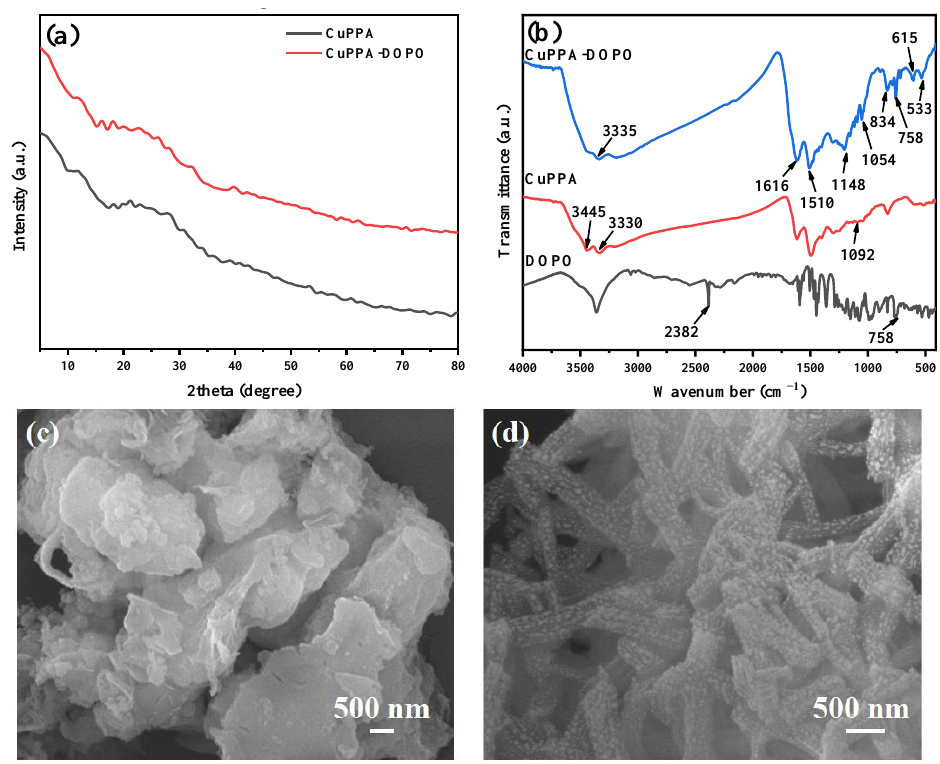
Figure 1. ( a ) XRD patterns of CuPPA and CuPPA-DOPO; ( b ) FTIR spectra of CuPPA and CuPPA- DOPO; ( c ) SEM image of CuPPA; ( d ) SEM image of CuPPA-DOPO. The thermal decomposition behavior of CuPPA, DOPO and CuPPA-DOPO was ob- tained by TGA, as plotted in Figure 2. The decomposition of CuPPA-DOPO has three stages of weightlessness. The first weight loss (5.8 wt%) occurred at 30 – 105 °C, and was mainly the desorption of adsorbed water and a small amount of organic solvents [28]. The next weight loss was 14.2 wt% after 105 – 306 °C, accompanied by the decomposition of phosphaphenanthrene into small molecules [29]. The most intense weight loss was 52.0 wt% after 306 °C, attributable to the decomposition of metal compounds and the oxidation of organic molecules such as phosphonates, the phase of which coincided with the decom- position temperature of EP [30].